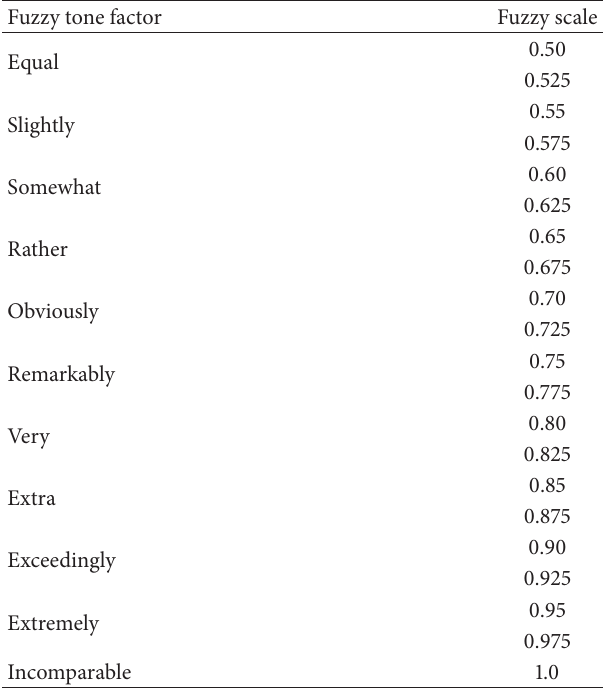
Table 1: The table of the relationship between fuzzy tone factor and fuzzy